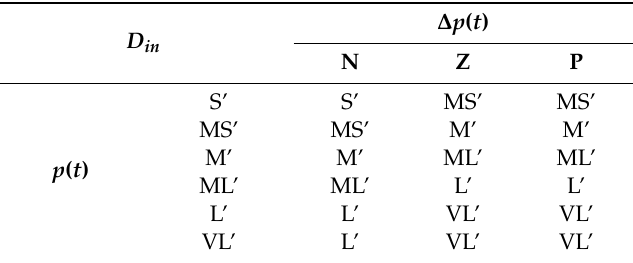
Table 5. The fuzzy control rules of the inlet valve.